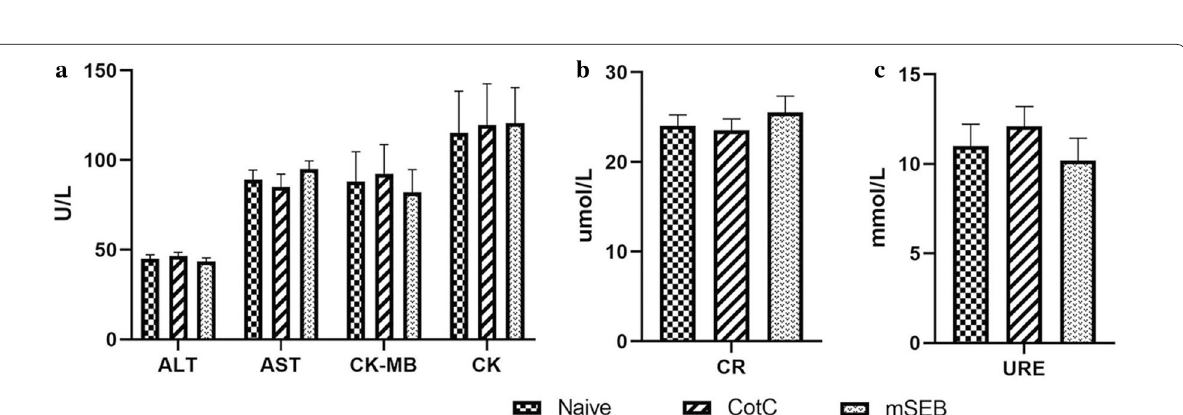
Fig. 6 The biochemical parameters in serum. After 6 weeks treatment, the biomedical indices of ALT, AST, CK-MB, CK, CR and URE in serum was analyzed by automated clinical chemistry analyzer. a ALT, AST, CK-MB and CK level, b CR level, c URE